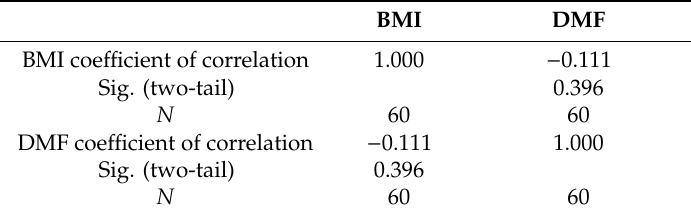
Table 17. Data related to the correlation between BMI and DMF in normal occlusion patients. BMI DMF